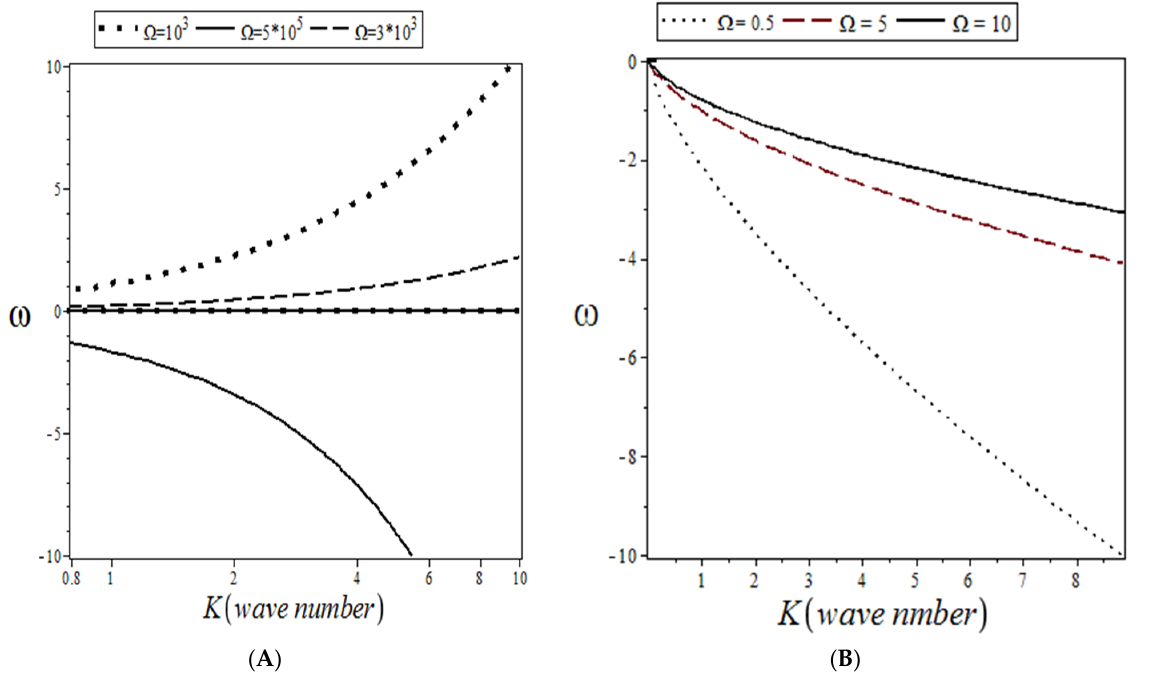
Figure 6. ( A , B ) Growth rate of the most dangerous mode as a function of the wave number b for ε 3 = − 7.234118786 × 10 − 36 and different large and small values of the rotation parameter under initial hydrostatic stress according to the MGT model. Figure 7 indicates the short-wavelength stability limit, where the growth rate decreases regularly when increasing the wave number b = K (variable, from K = 0) and tends towards a minimum value ω ( ω = − 0.256410257) when the wave number K becomes small ( b = 0.25641026).